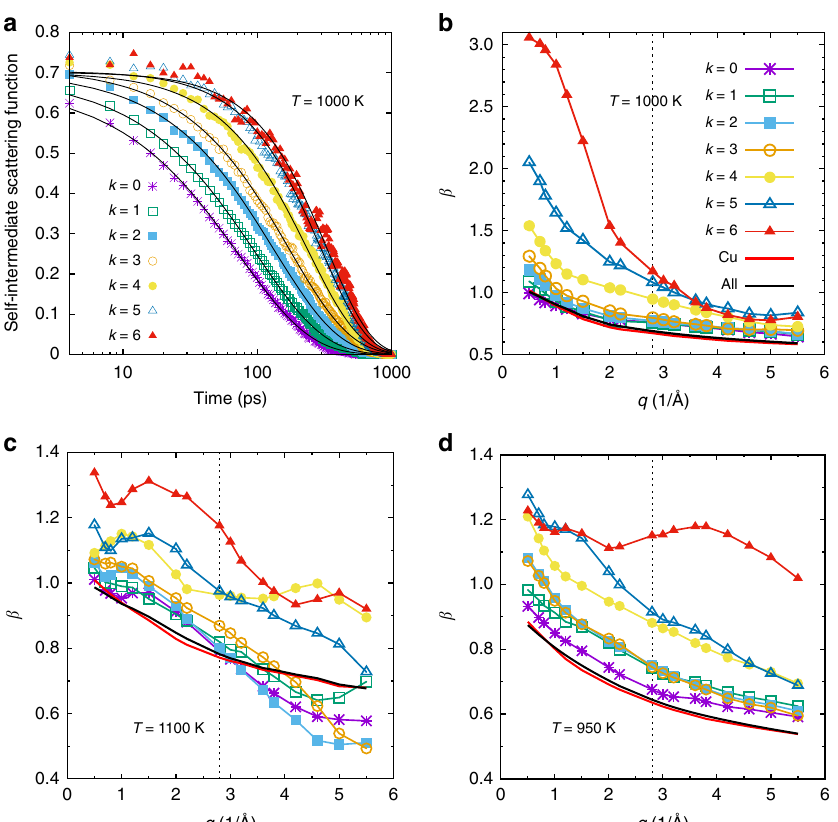
Fig. 3 Relaxation dynamics of the system at intermediate and long times. a Self-intermediate scattering function at wave-vector q = 2.8 Å − 1 for different values of connectivity k of the Cu atoms. T = 1000 K. b q- dependence of the KWW exponent β for different values of k . Also included is the data obtained if one averages over all Cu atoms and all atoms at T = 1000 K. c , d show β for temperatures T = 1100 K and 50 K, respectively. The vertical dashed line in b – d shows the position of the main peak in the static structure